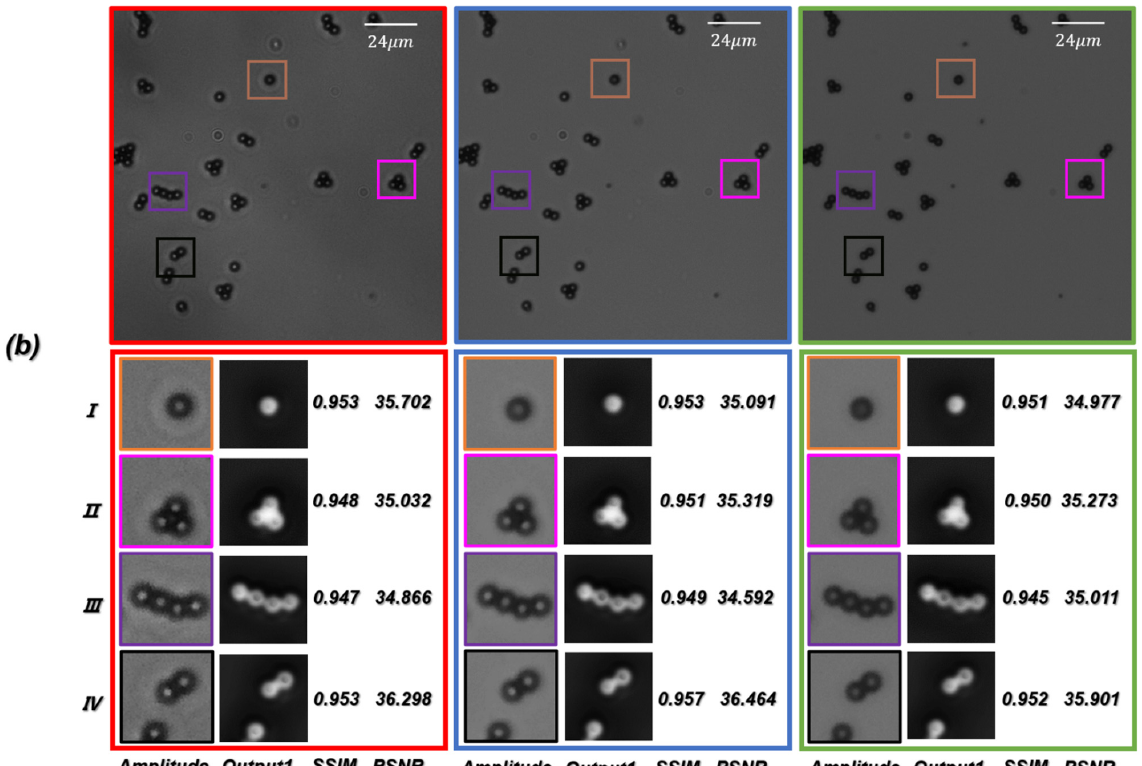
Figure 11. ( a ) Test results of the LR out-of-focus microscopic images. ( b ) Test results of the LR microscopic images with different contrast captured at different apertures of the concentrator.